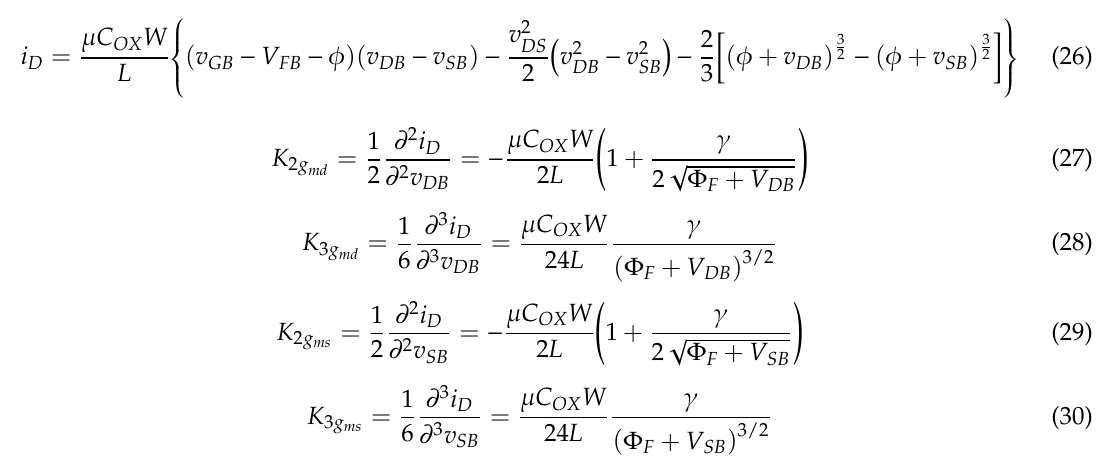
Figure 11. Simulation results of